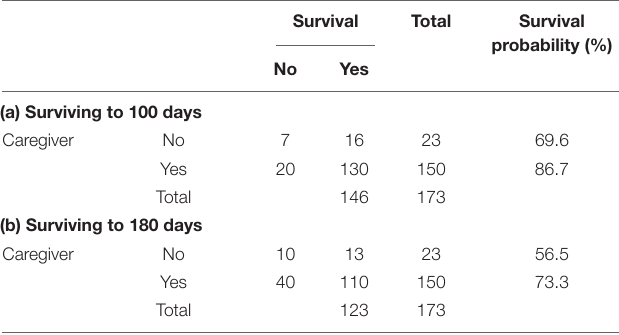
TABLE 1 | Availability of caregiver and frequencies and probabilities of surviving to 100 and 180 days after transplant. Survival Total Survival probability (%)